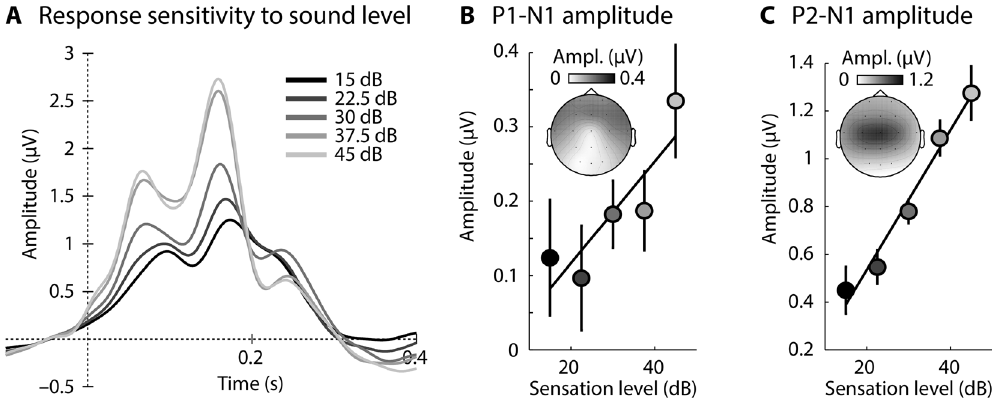
Figure 3. Overall response sensitivity to sound level (across sound-level contexts). ( A) Response time courses for five different sound-level categories (averaged across a fronto-central electrode cluster). ( B) P1-N1 peak-to- peak amplitude for each sound level. The solid line reflects the averaged slope of the linear fit. Error bars reflect the standard error of the mean (removal of between-subject variance 67 ). ( C ) Same as in panel B for P2-N1 peak- to-peak